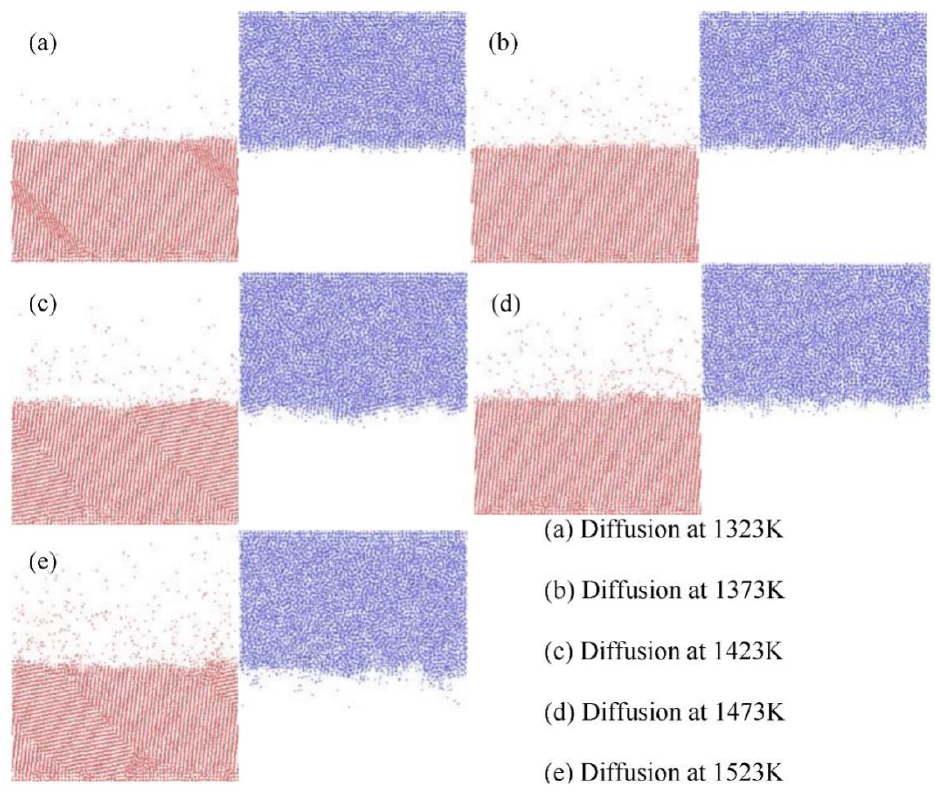
Figure 3. Snapshots of Fe/Cu interface after simulation for 3 ns obtained at ( a ) 1323 K, ( b ) 1373 K, ( c ) 1423 K, ( d ) 1473 K, and ( e ) 1523 K. (Red spheres represent Fe atoms, and blue spheres represent Cu atoms).